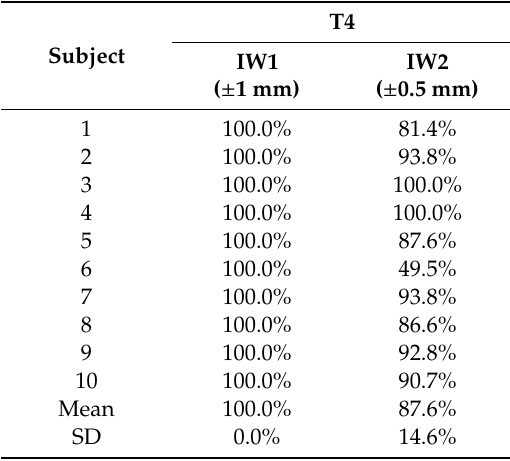
Table 1. Mean percentage and standard deviation (SD) of the traced lines falling within the inspection window (IW) of the two templates used to evaluate the two accuracy levels ( ± 1 mm, IW1 = 2.5 mm; ± 0.5 mm, IW2 = 1.5 mm) for the tested T4 trajectory. T4 Subject IW1 IW2 ( ± 1 mm) ( ± 0.5 mm)